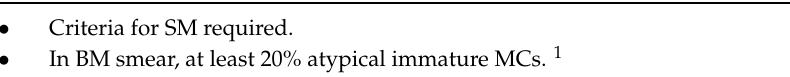
Table 1. Diagnostic criteria for MCL.